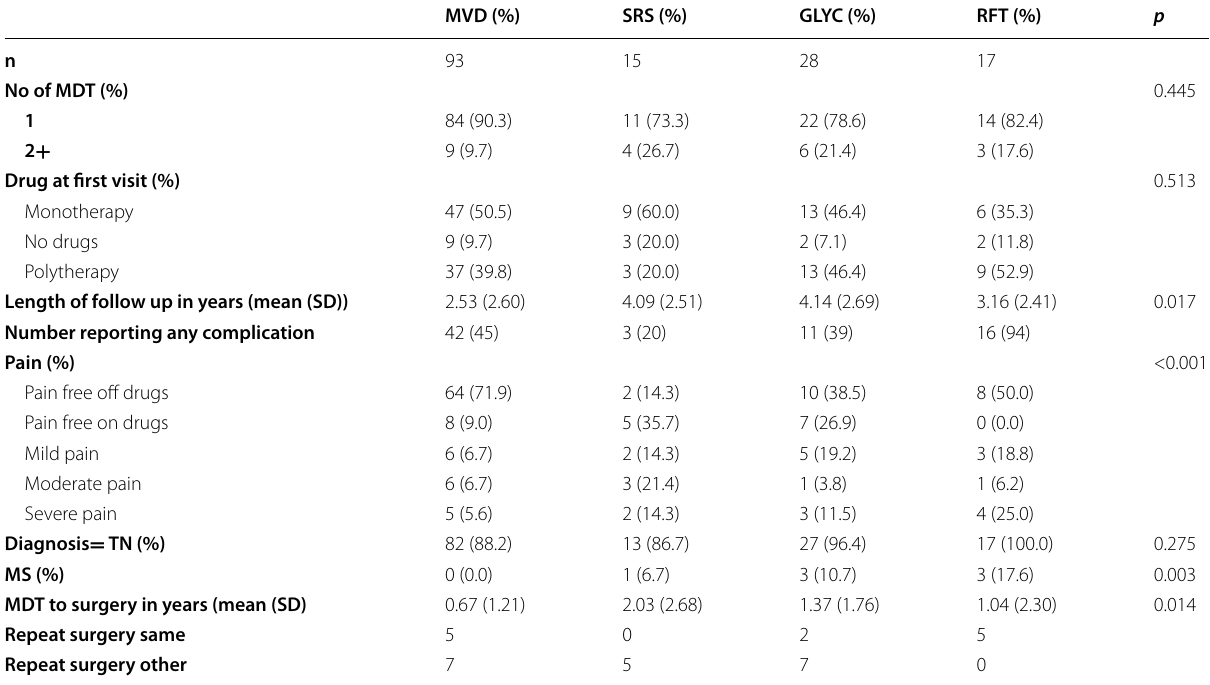
Table 3 Results of surgical